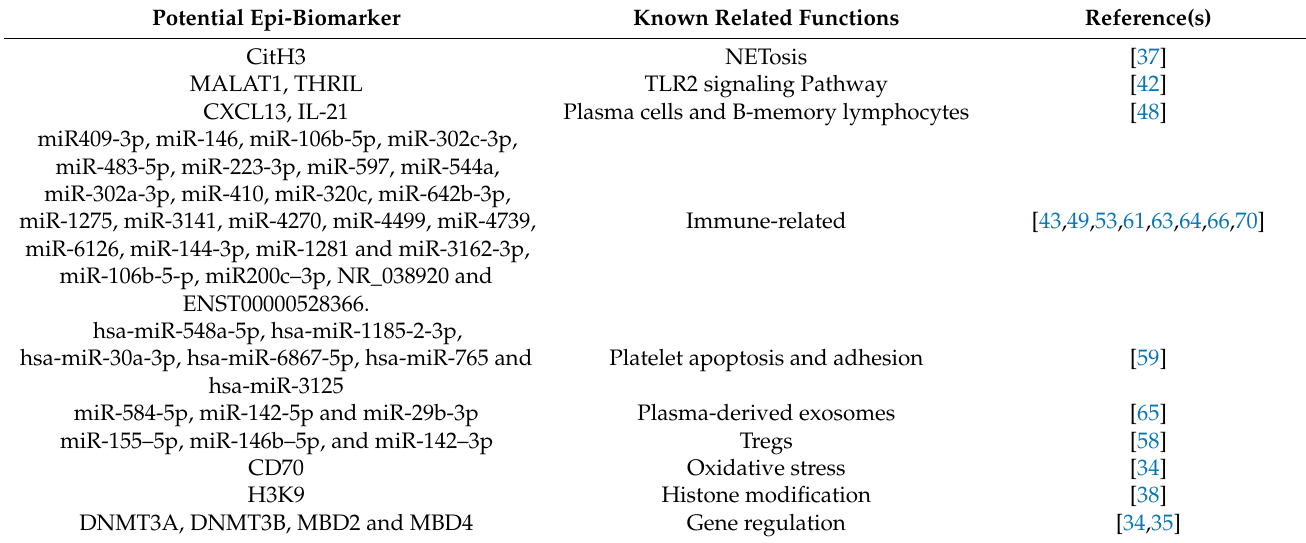
Table 2. Potential Epi-biomarkers for Immune Thrombocytopenia Purpura